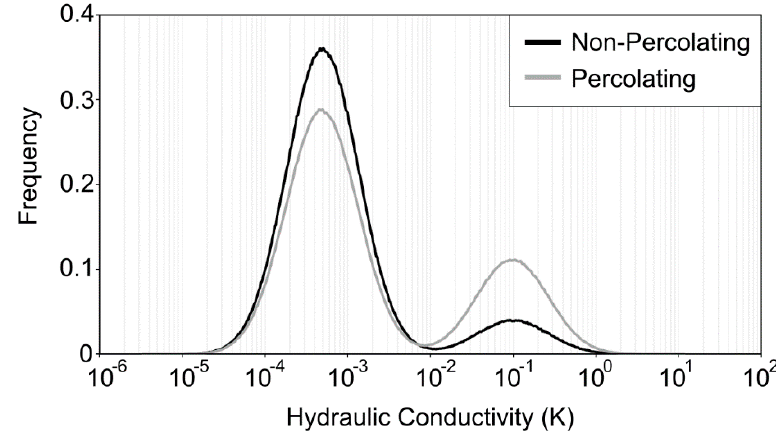
Figure 2. Frequency plot of hydraulic conductivity in heterogeneous simulations. Di ff erence in mean Figure 2 . Frequency plot of hydraulic conductivity in heterogeneous simulations. Difference in mean ln(K) is clear for both percolating and non-percolating ln(K) is clear for both percolating and non-percolating cases.